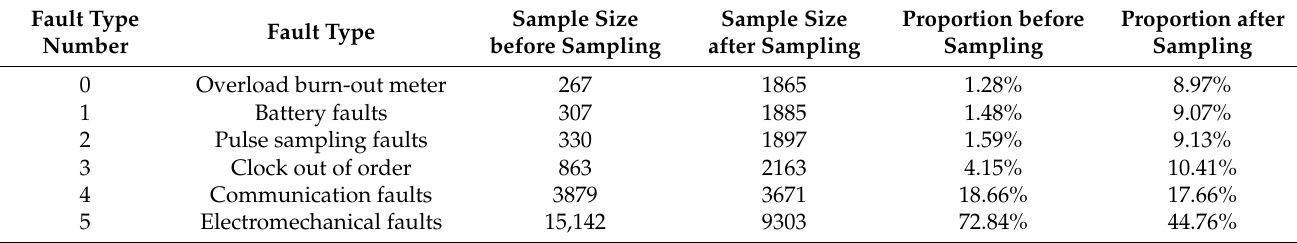
Table 1. Change in sample proportion after mixed sampling